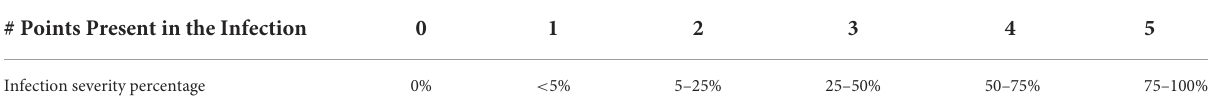
TABLE 2 Lobe infection severity percentage categorized by the number of